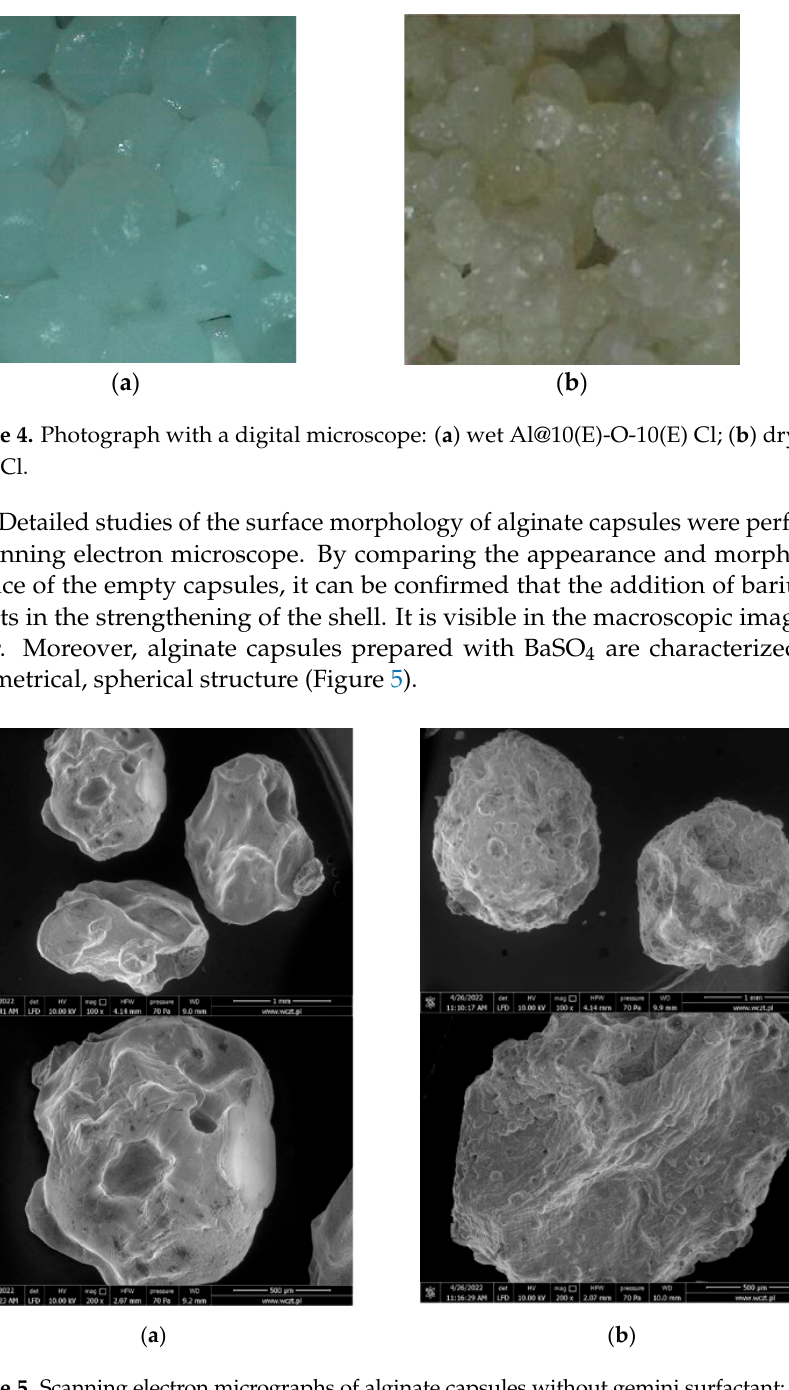
( b ) Figure 6. Scanning electron micrographs of alginate capsules with gemini surfactants. ( a ) Al@12-O-12; ( b ) Al@12-O-12+BaSO 4 .